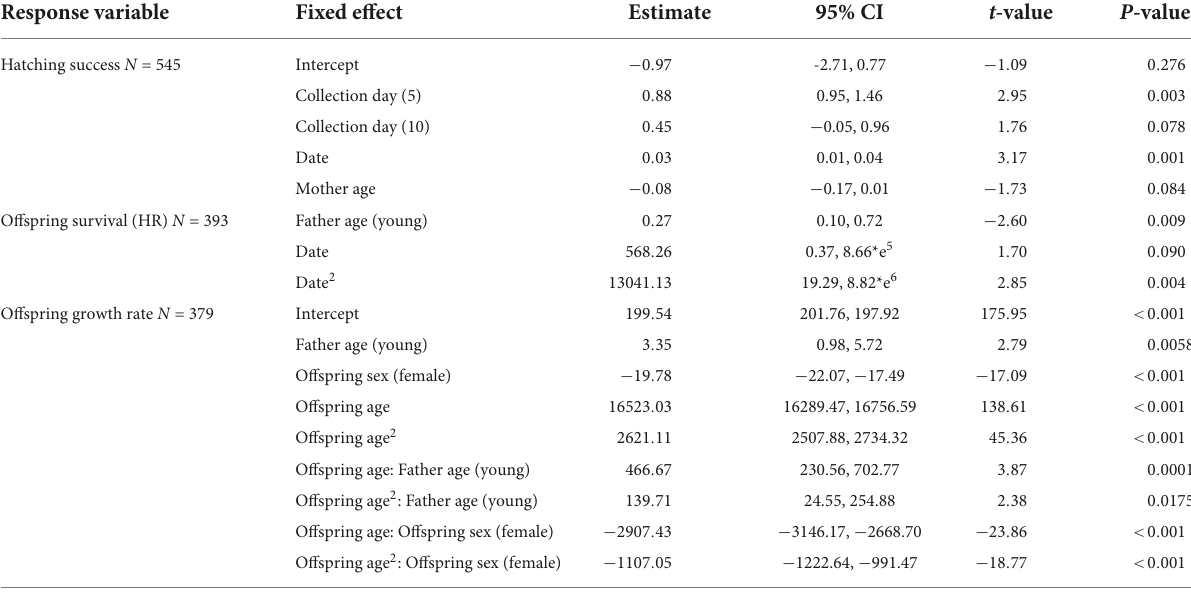
TABLE 3 Selected parsimonious generalized mixed linear models exploring the effect of male and sperm age on hatching success, offspring survival and growth rate.